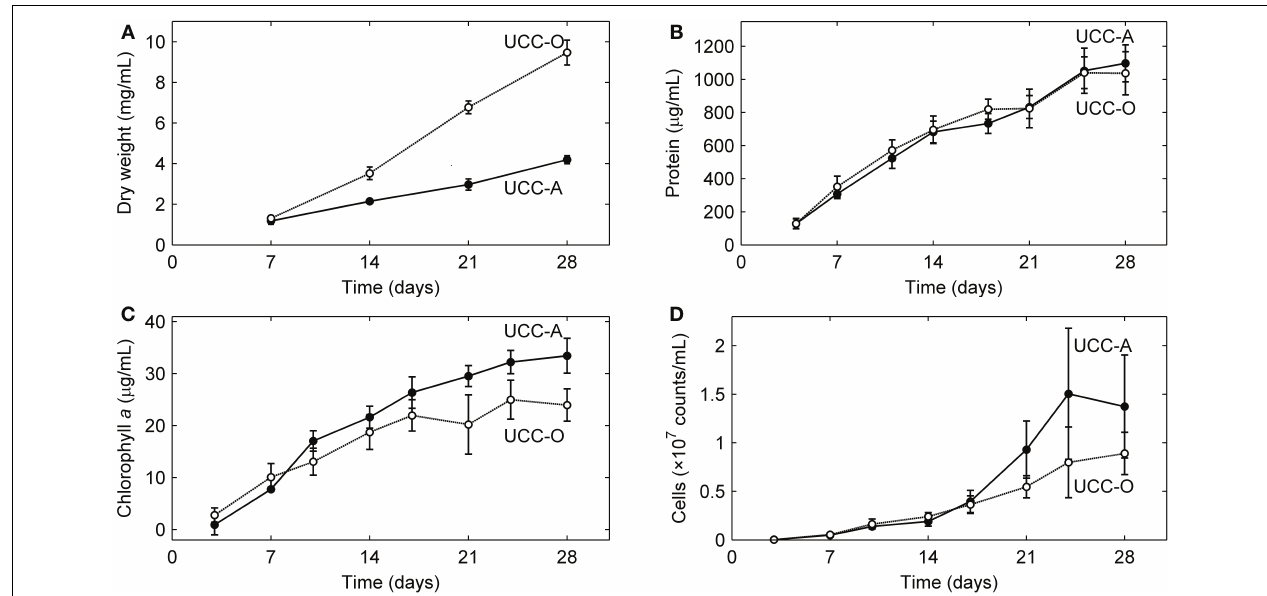
FIGURE 5 | Growth kinetics of the consortial biofilms. Changes in biomass concentration of each unicyanobacterial consortium were measured as a function of time using (A) dry weight, (B) total protein, (C) chlorophyll a ,